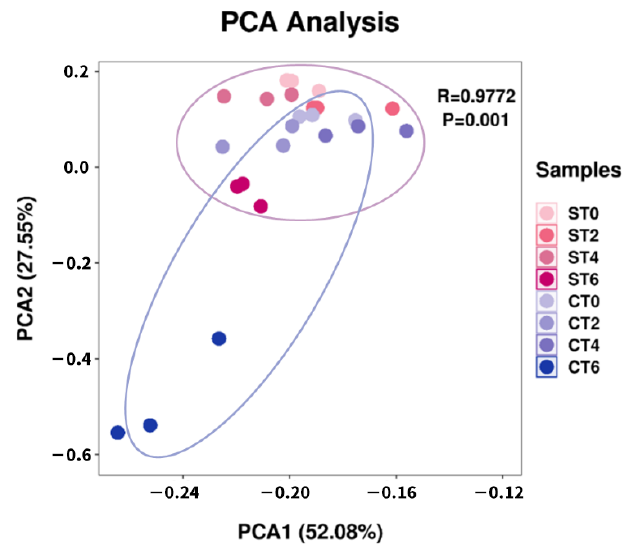
Figure 2. Principal component analysis of intestinal microbiota (ST—aqueous extract group; CT—alcohol extract group; 0—no sample added; 2, 4, 6 denote fermentation days after sample addition).